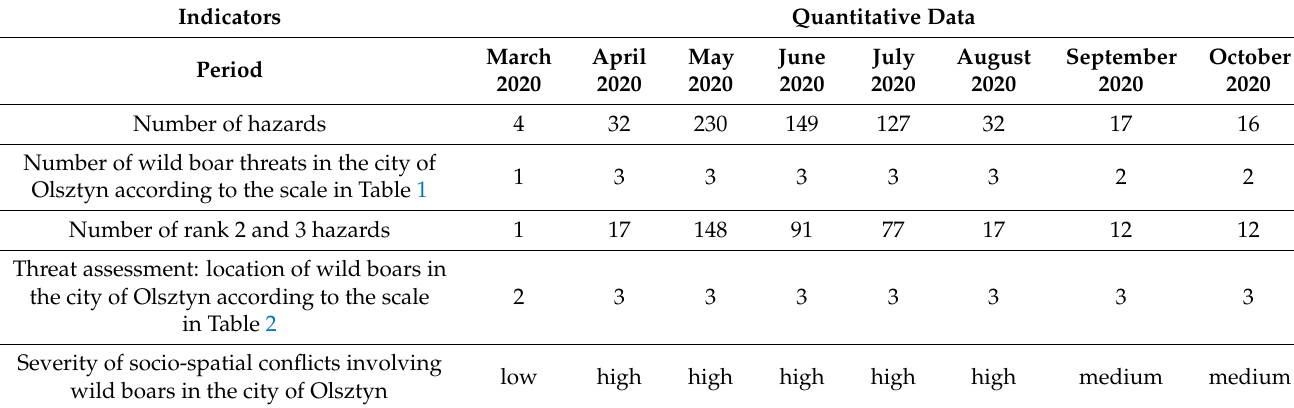
Table 4. Results of the photointerpretation-based analysis of crowdsourced multimedia files.